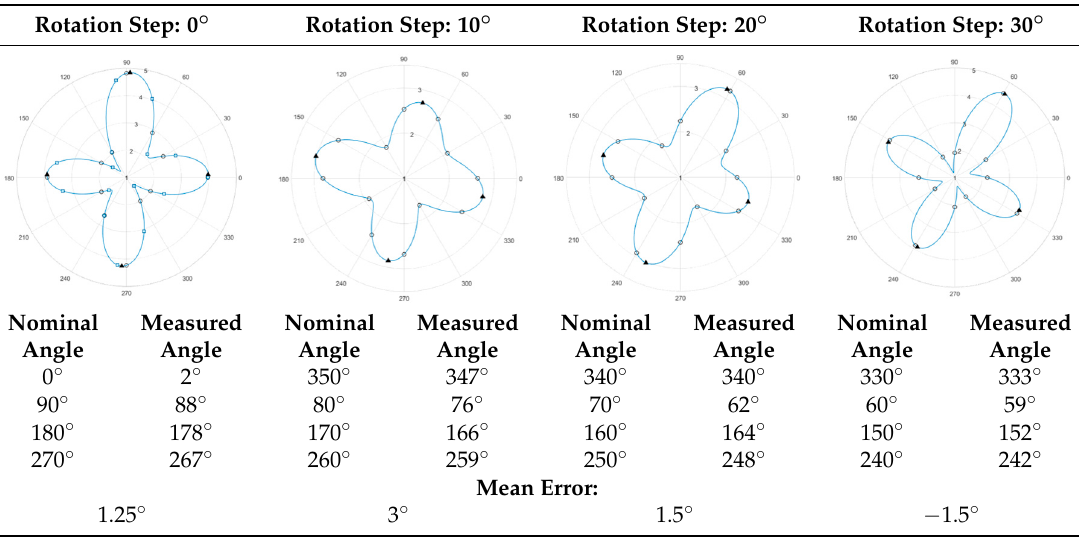
Table 2. Eddy current sensor array measurements.